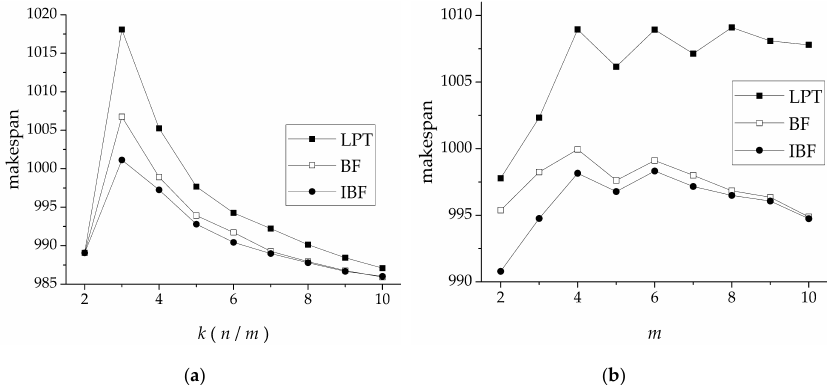
Figure 7. Comparison of LPT, bound fit (BF), and IBF in terms of makespan with ( a ) variable k (ratio of the number of tasks n and the number of fine delay modules m ) and ( b ) variable number of fine delay modules m .